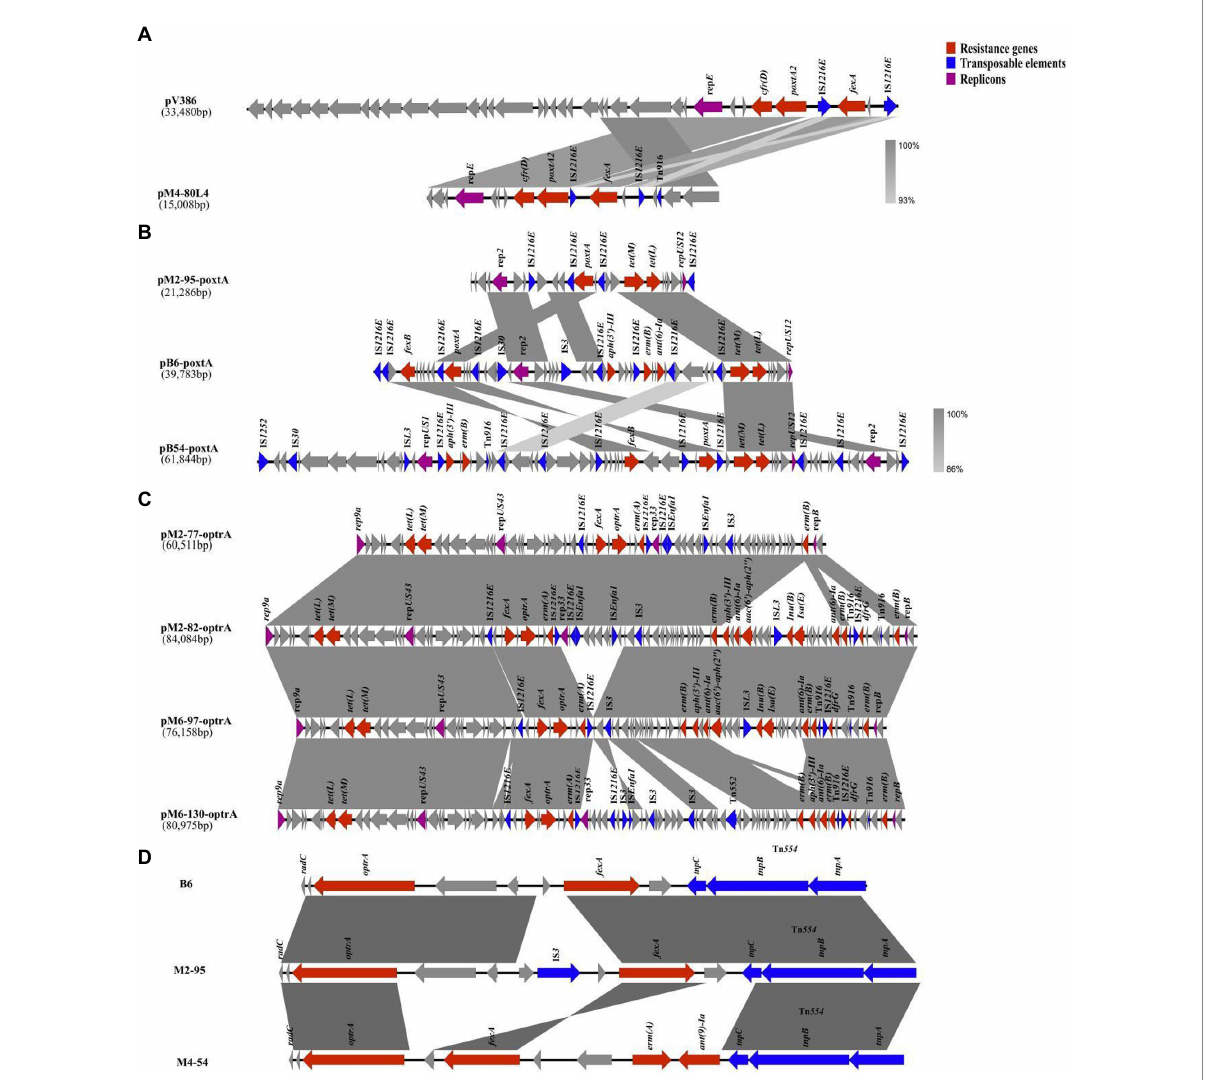
FIGURE 3 The genetic environments of different oxazolidinone resistance genes. Genes and ORFs are shown as arrows, and their transcription orientations are indicated by the arrowheads. (A) The genetic structure of pM4-80L4. (B) The genetic structures of three poxtA-carrying plasmids. (C) The genetic structures of four optrA-carrying plasmids. (D) The genetic structures of three different chromosomal optrA gene